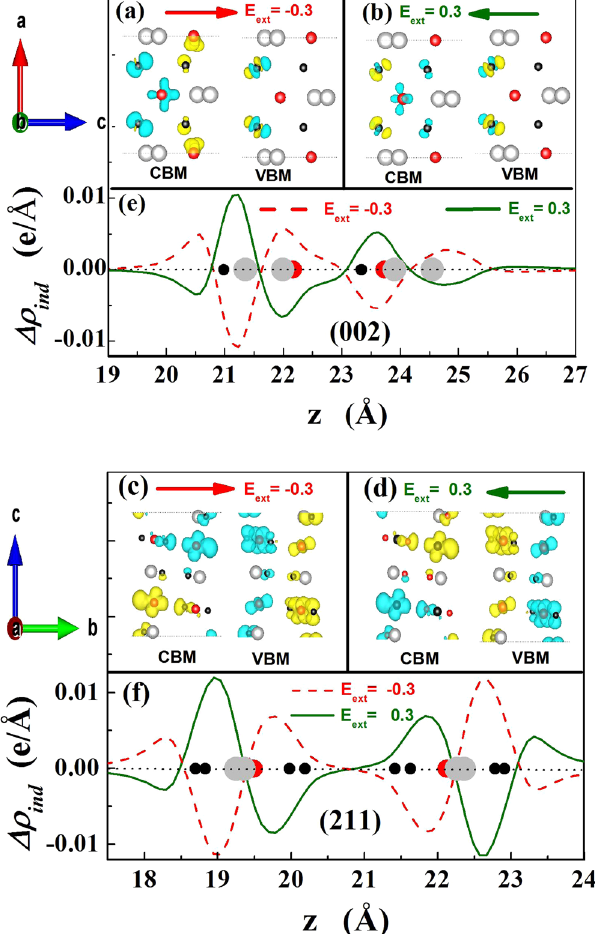
Figure 5. Side view of induced charge density of the CBM and VBM under external electric fields with isosurface value of 0.0009 e/au 3 for (002) slab with ( a ) E ext = − 0.3 V/Å and ( b ) E ext = 0.3 V/Å; for (211) slab with ( c ) E ext = − 0.3 V/Å and ( d ) E ext = 0.3 V/Å. The yellow and blue colors indicate electron accumulation and depletion, respectively. The induced plane-averaged charge density change,